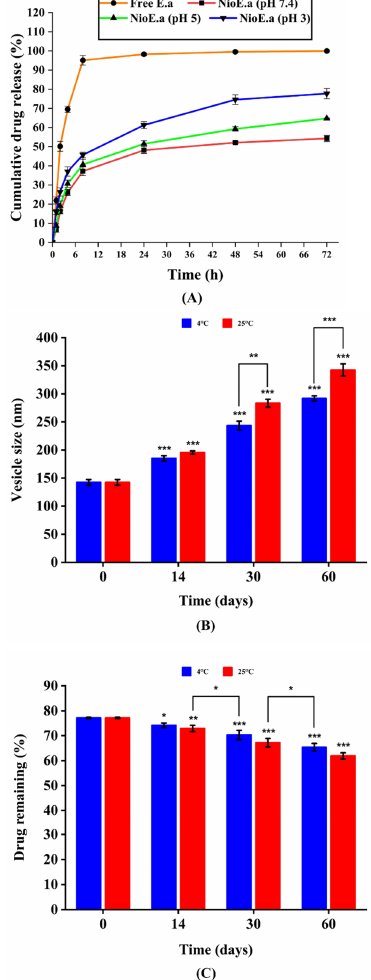
Figure 3. ( A ) In vitro drug release profile of E. angustifolia extracts at different pH from the optimized formulation of drug-loaded niosomes. Free Ea: free E. angustifolia extracts; NioEa (pH 3), NioEa (pH 5) and NioEa (pH 7.4): niosome-encapsulated E. angustifolia extracts kept at pH 3, pH 5, and pH 7.4, respectively. N = 3. Stability in respect to vesicle size ( B ) and Drug remaining ( C ) of optimum E. angustifolia -loaded niosomes during 60 days of storage at 4 ± 2 and 25 ± 2 °C. N = 3. ***: p < 0.001, **: p < 0.01, *: p < 0.05. Lower pH promoted a considerable increase of E. angustifolia drug release, likely due to swelling/breaking of niosomal structures at acidic pH [48]. Another reason for the pH- dependent response of the niosomal system could be the immense hydrolysis rate of sur- factants (i.e., Span 60 and Tween 60) at acidic pH, which caused a break-out in drug mol- ecules’ release at acidic conditions [49]. The lipid bilayer structure of niosomes assures that the entrapped E. angustifolia moves across the cell membrane, causing sustained re- lease at physiological pH. Drug release and its crossing through a bilayer membrane de- pend on the fluidness and the structure of the bilayer membrane. In this regard, the elec- trostatic interaction between drugs and surfactants plays a decisive role, chiefly, under ionized conditions at a physiological pH [50]. This pH-dependent reaction plays a critical role in cancer cells, which habitually have acidic pH compared to healthy cells. The pH- dependent release can also be of advantage for treatment of dental carries, which is the